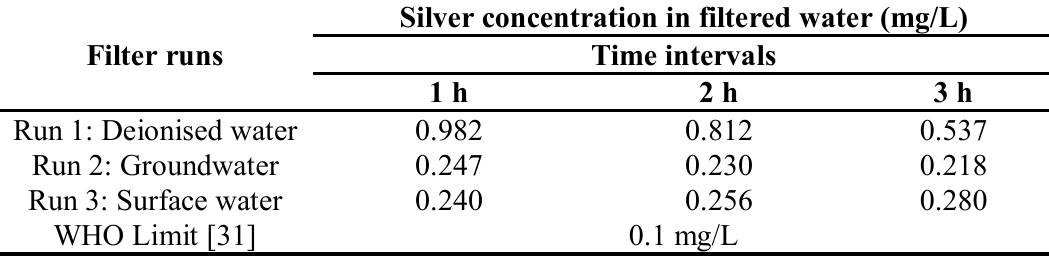
Table 8. Silver concentration in filtered water.